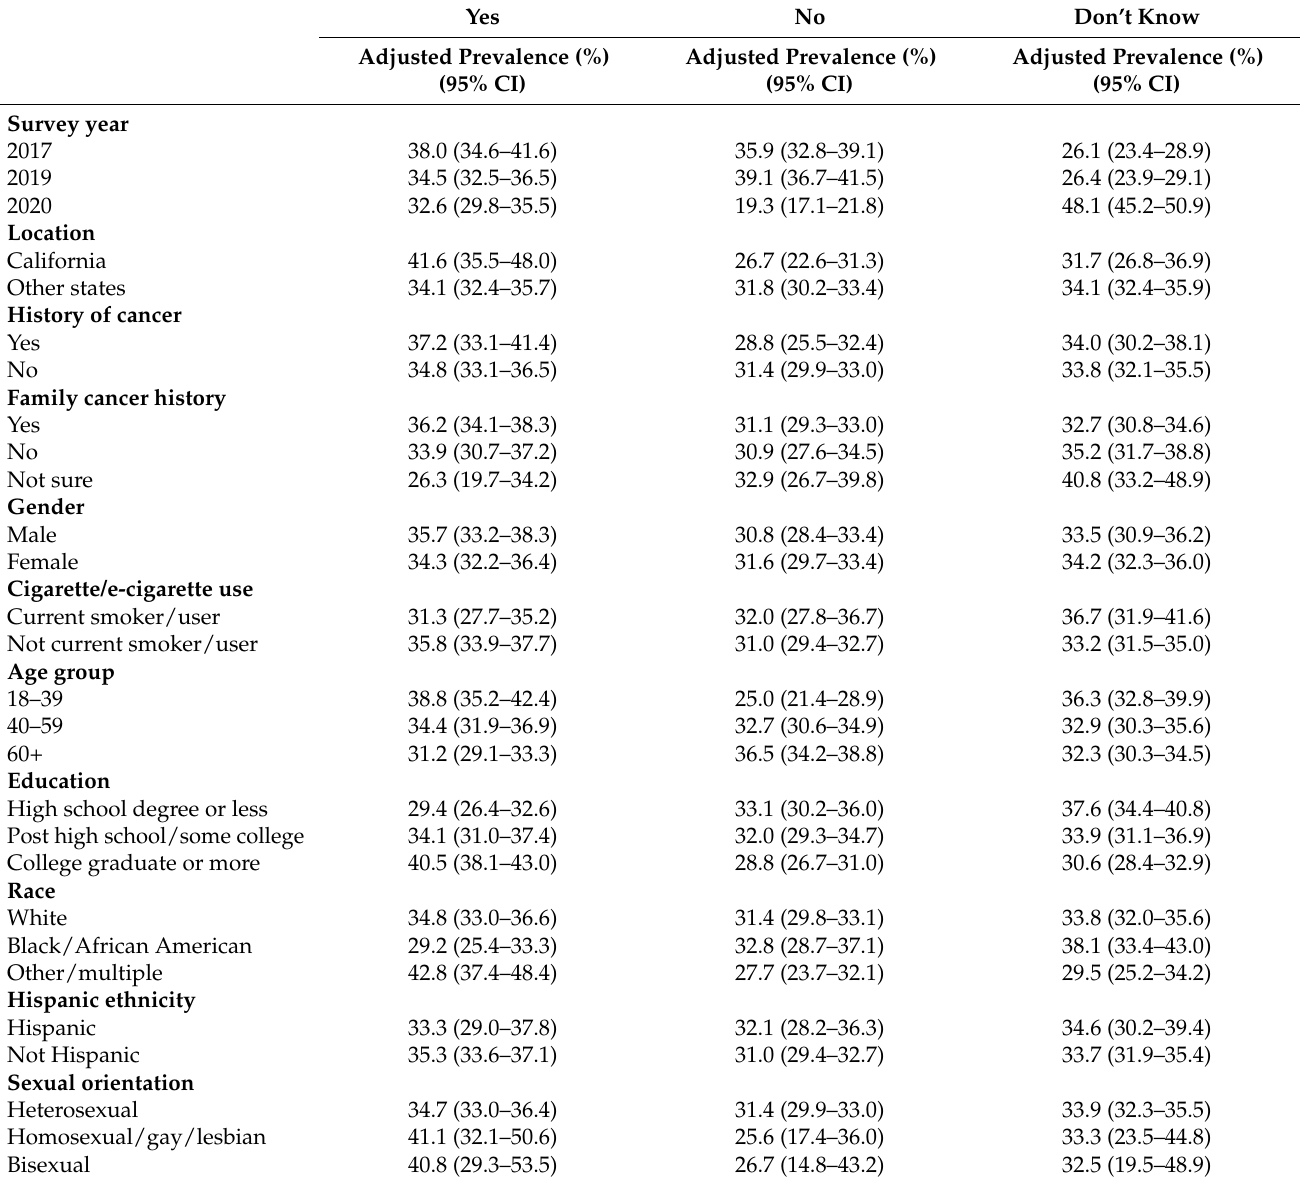
Table 3. Predicted marginals of alcohol and cancer knowledge a estimated from logistic regression models b